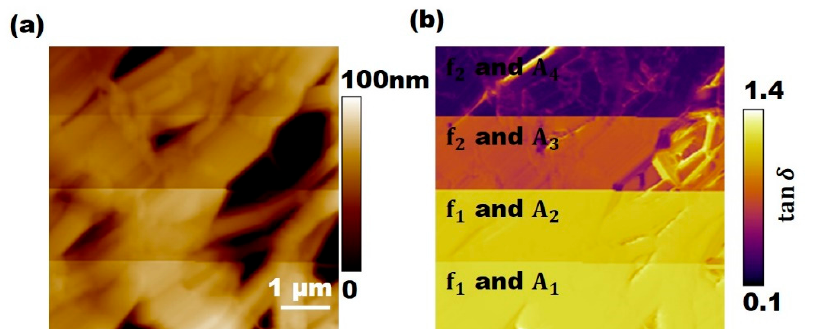
Figure 3. PTFE loss tangent AFM study: ( a ) topography image and ( b ) tan δ image. From bottom to top, the excitation frequency and free oscillation amplitudes are as follows: f 1 = 72 kHz and A 1 = 50 nm, f 1 = 72 kHz and A 2 = 100 nm, f 2 = 460 kHz and A 3 = 1.5 nm, and f 2 = 460kHz and A 4 = 3.5 nm. The scale bar is 1 µ m